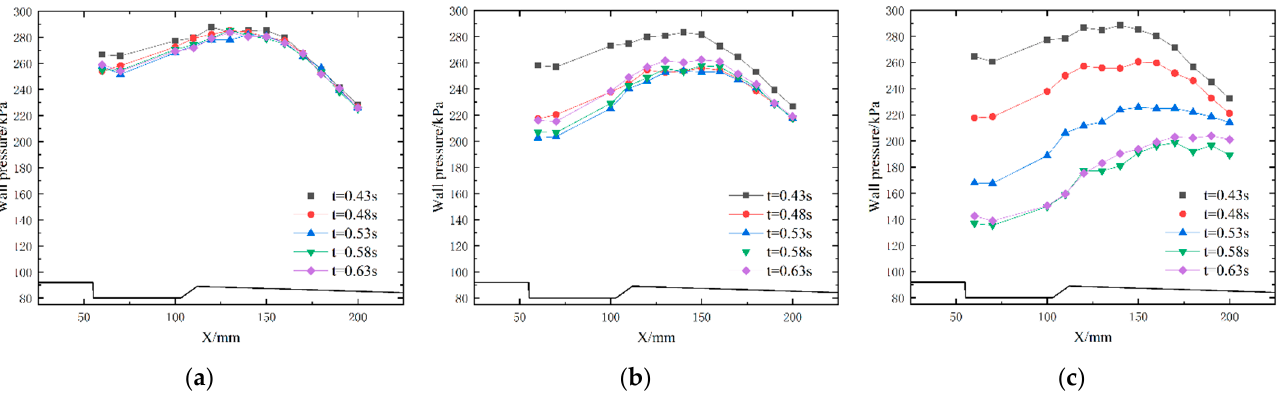
Figure 11. Change in the wall pressure profiles with time during condition transition. ( a ) Case 1. ( b ) Case 2. ( c ) Case 3.